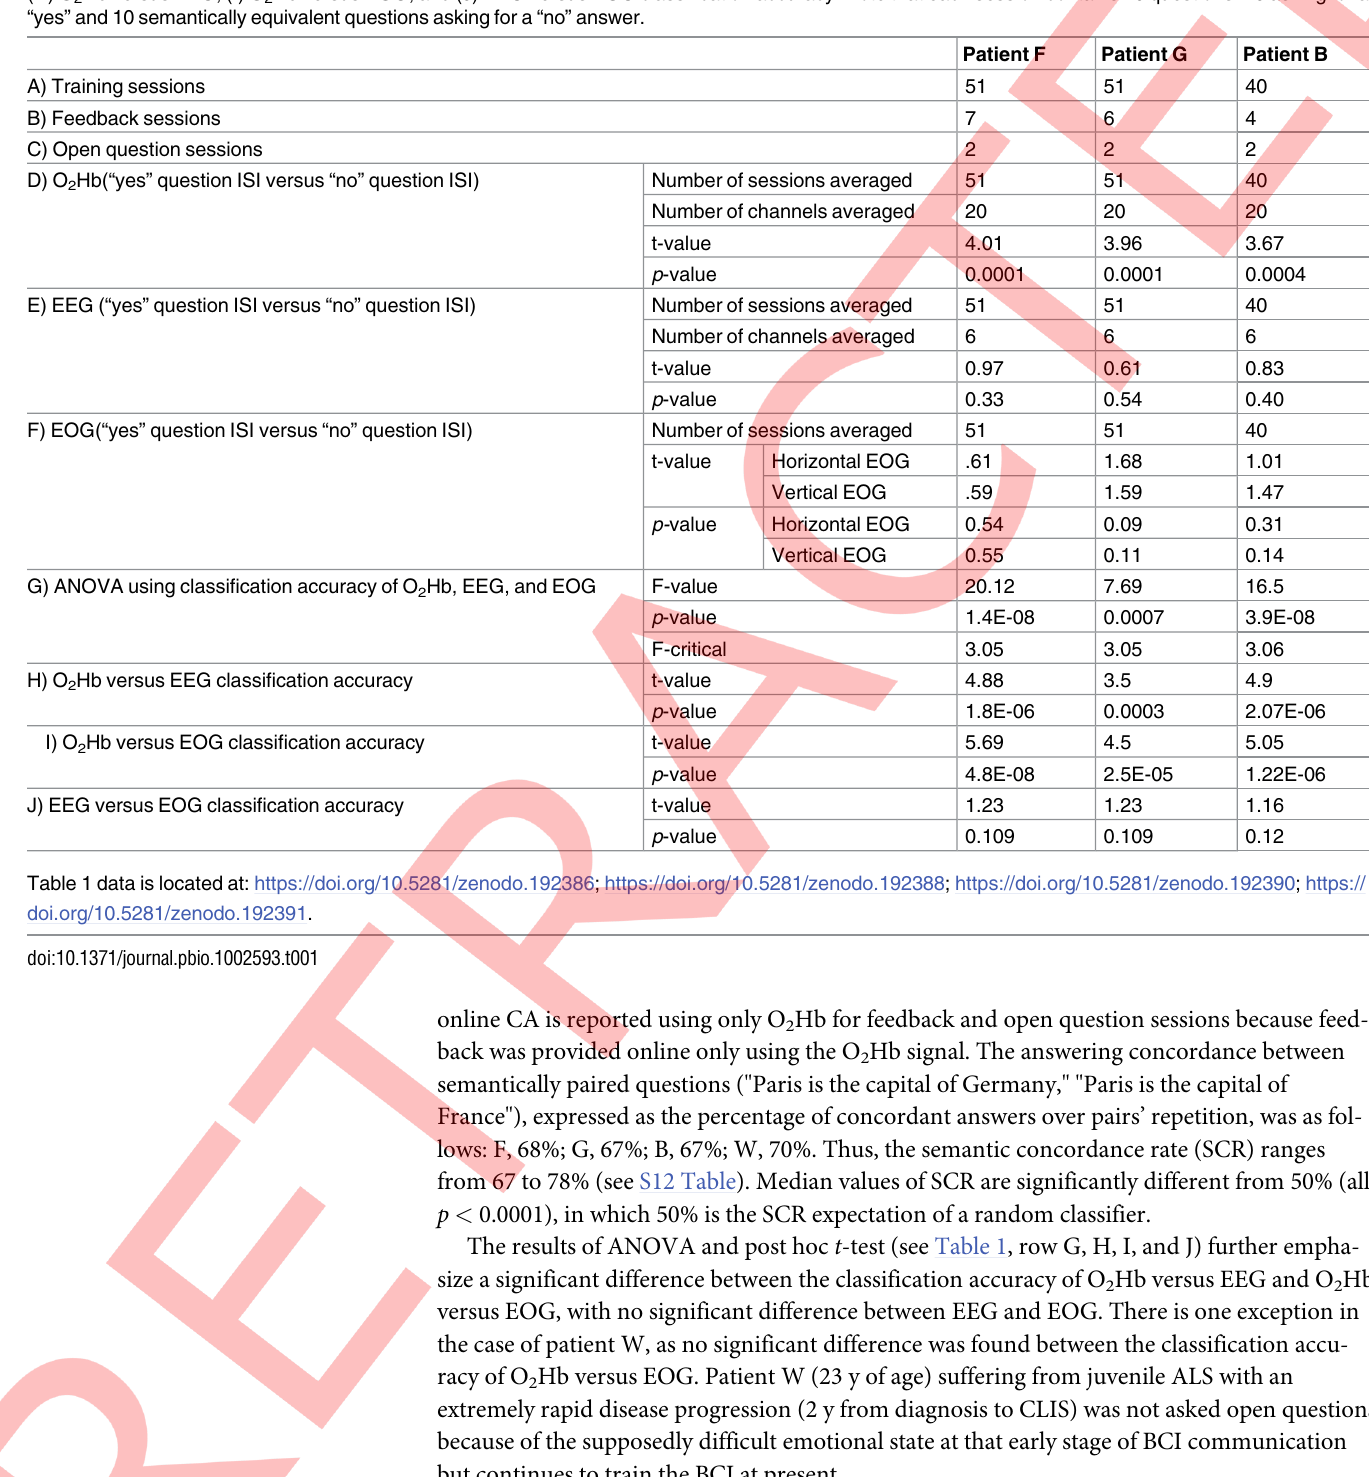
Table 1. Statistics Results. Total number of (A) training, (B) feedback, and (C) open questionsessionsperformed by each patient. The total number of ses- sions averagedand degreesof freedom used to perform t -tests betweenthe true and false sentences’ ISI correspondingto (D) O 2 Hb, (E) EEG, and (F) EOG signals. (G) ANOVA using support vector machine(SVM) classification accuracy (CA) of O 2 Hb, EEG, and EOG signals. Post hoc t -test performed between (H) O